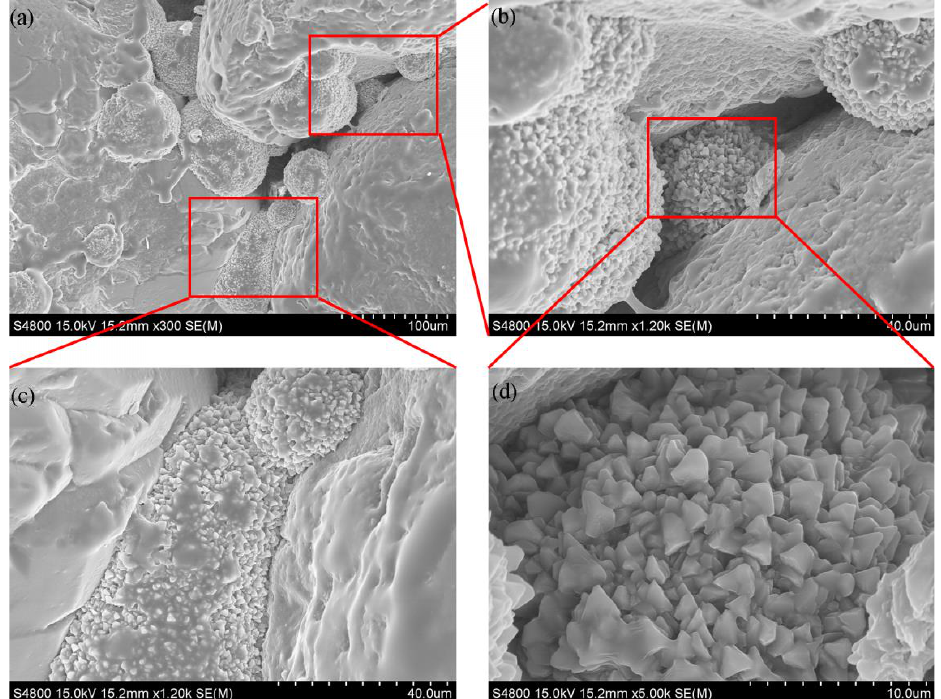
Figure 10. SEM images of EICP-treated (60 g/L powdered soybean) sand samples at eight treatments level with a magnification of: ( a ) 300 time; ( b , c ) 1200 time; ( d ) 5000 times. After eight cycles of treatment, the typical stress – strain curves of the biocemented soil samples treated with different powdered soybean concentrations were obtained and are presented in Figure 11a. All the EICP-treated sand samples exhibited a brittle nature comparable to those observed in the MICP [11,34] and EICP [35,42] treatments. During the unconfined compressive tests, failures tended to occur within the whole core (Figure 11b). This result was in line with the relatively uniform distribution of CaCO 3 precipita- tion in the sand columns (Figure 12). A low-temperature premixed percolation strategy